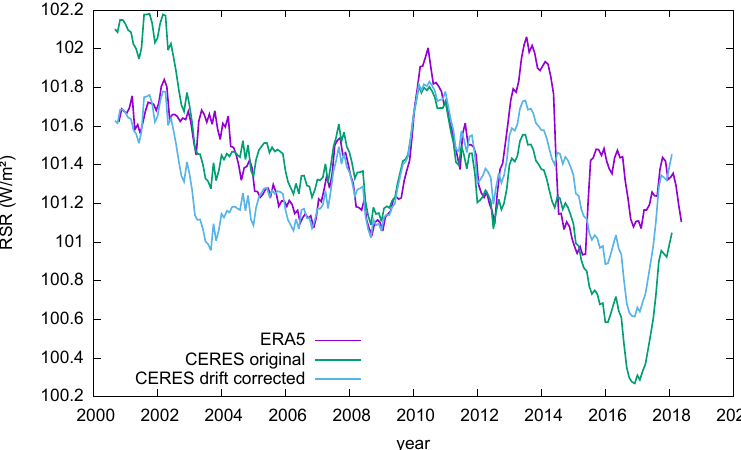
Figure 7. 2000–2018 variation in RSR. Purple curve: ERA 5 estimates. Green curve: actual CERES measurements. Blue curve: drift corrected CERES